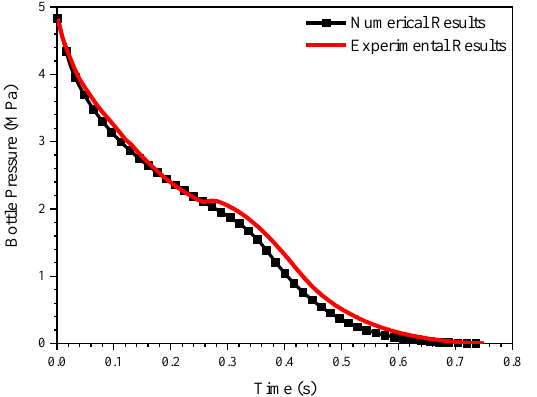
Figure 4. Comparison of numerical and experimental results of vessel pressure during release.